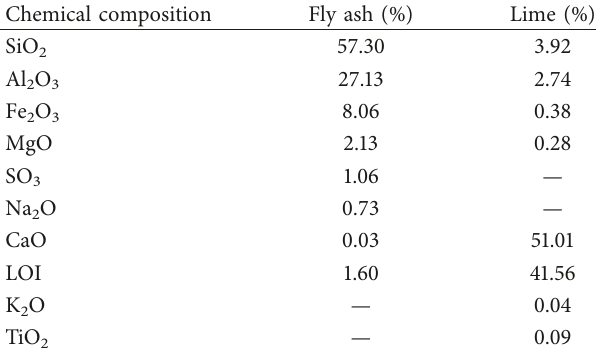
Table 1: Chemical composition of materials. Chemical